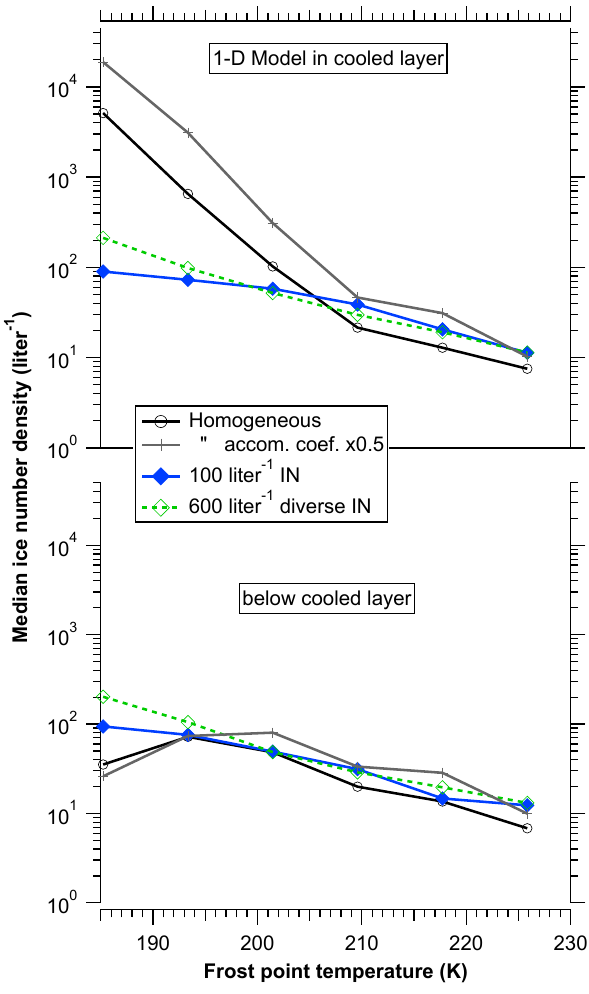
Figure 5. Ice number densities in the one-dimensional model. The values are the median over 20 temperature histories of the maximum in time averaged over vertical range either in or below the layer with imposed cooling. These ranges are indicated in Fig. 4. The axis ranges are the same as in Fig.